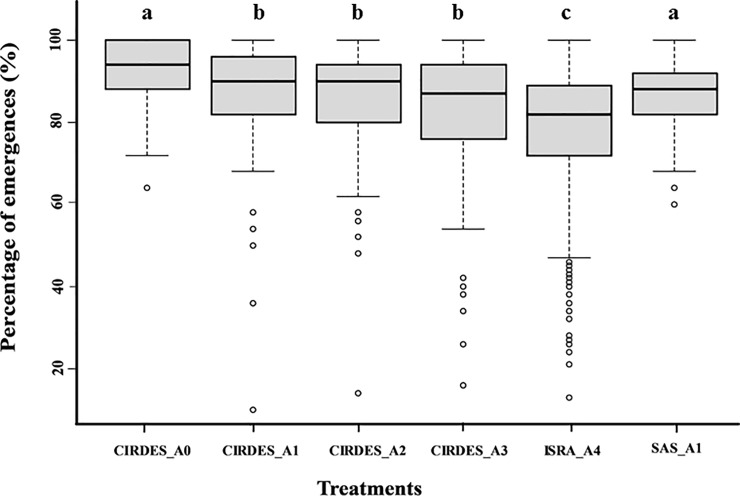
Percentage of emergence according to the treatment and sites.Boxes extend between the 25th and 75th percentile. A thick line denotes the median. The whiskers extend up to the most extreme values and white circles represent outlier data. Different letters indicate significant differences (P < 0.05).